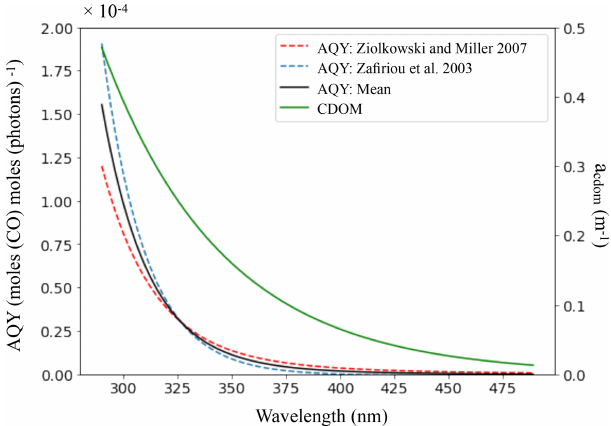
Figure 1. CO apparent quantum yield (AQY in moles of CO per moles of photons) and CDOM absorption coefficient ( a cdom in m − 1 ) as a function of the wavelength (nm). For the AQY, the pa- rameterizations of Ziolkowski and Miller (2007) and Zafiriou et al. (2003) are shown with dotted lines and the resulting mean re- lation used in PISCES is shown with a continuous line. For a cdom , the relation is shown for a Chl a concentration of 1mgm − 3 and is calculated according to the parameterization of Morel